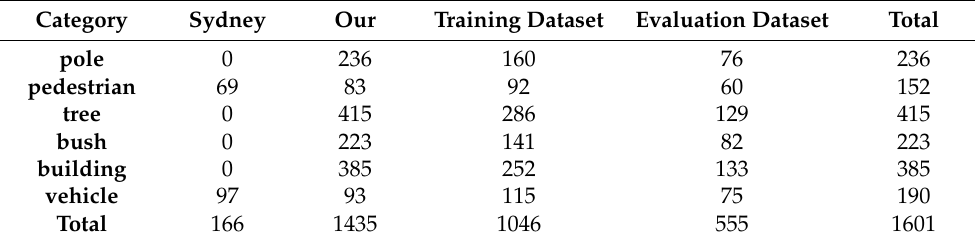
Table 1. LiDAR point cloud object classification training and testing dataset.